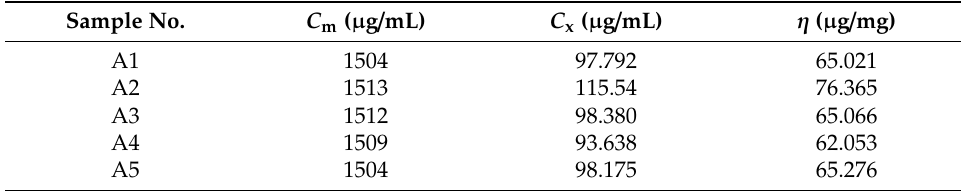
Table 5. Contents of Cy-3-glc in bilberry extract samples ( n = 3). Sample No.